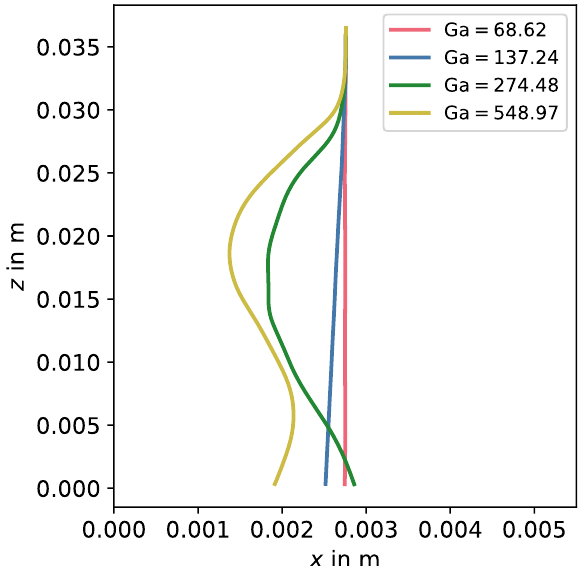
Figure 6. Path in the x - z -plane for spheres with different Ga.